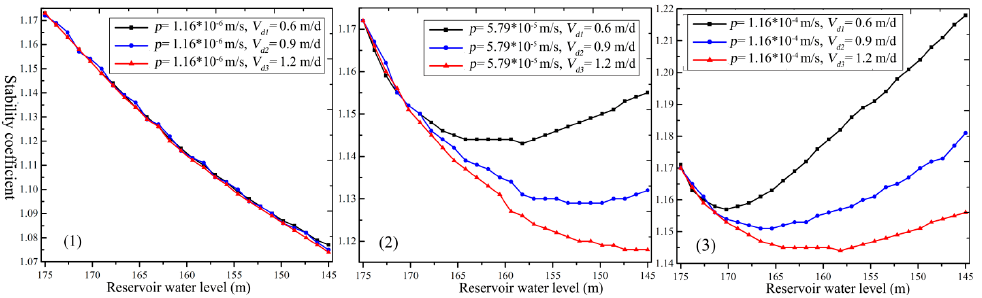
Figure 11. Comparison of the stability coefficient and water level drawdown for different permeability coefficients.